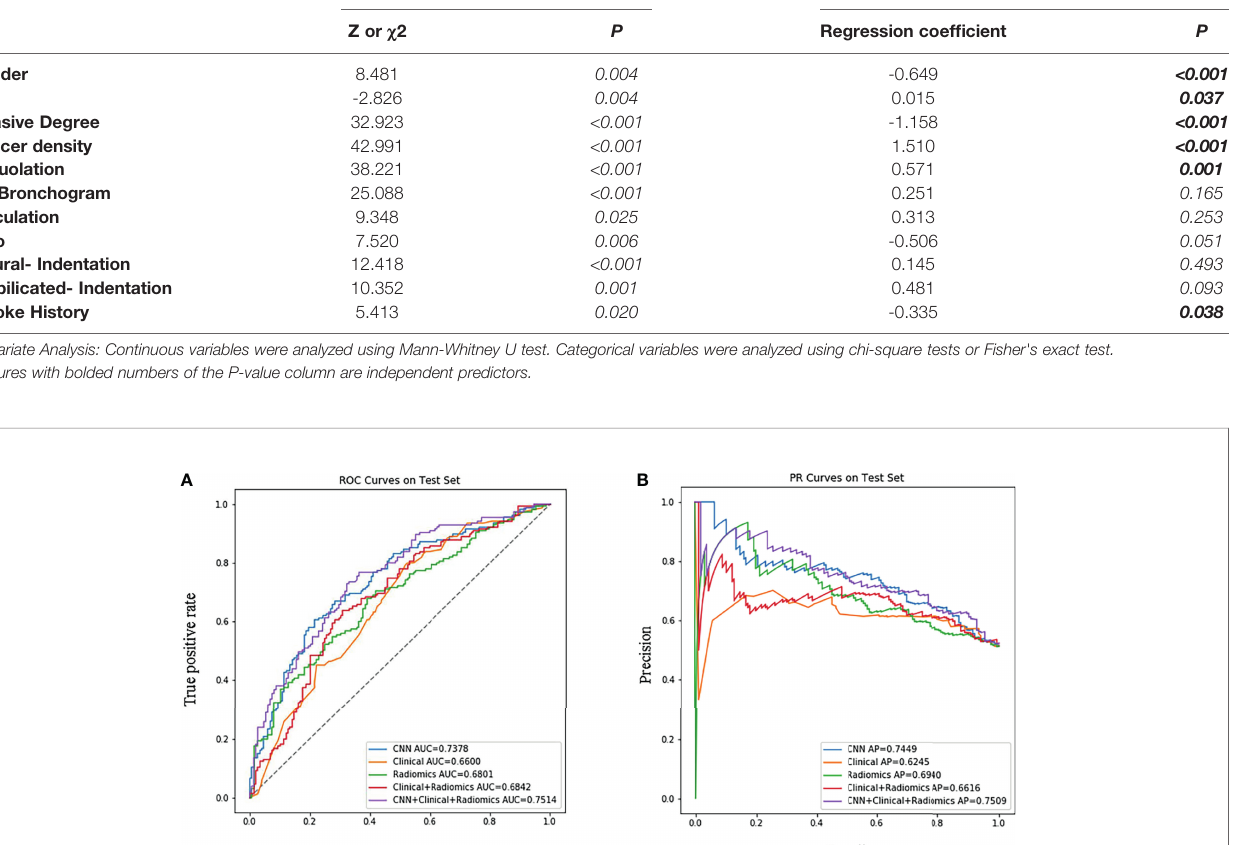
TABLE 2 | | Statistical analysis outcome of clinical-radiology characteristics. Selected